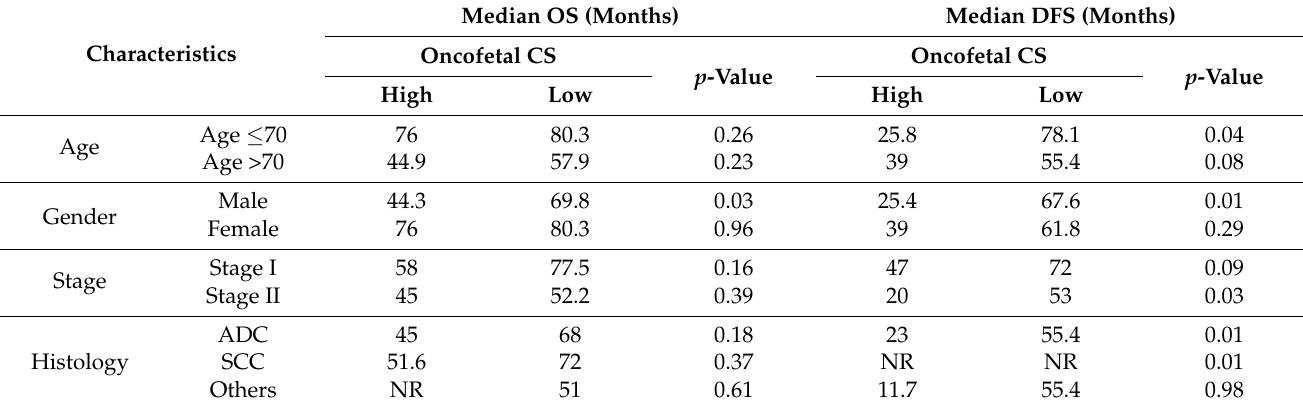
Table 2. Univariable Cox regression analyses of overall and disease-free survival.